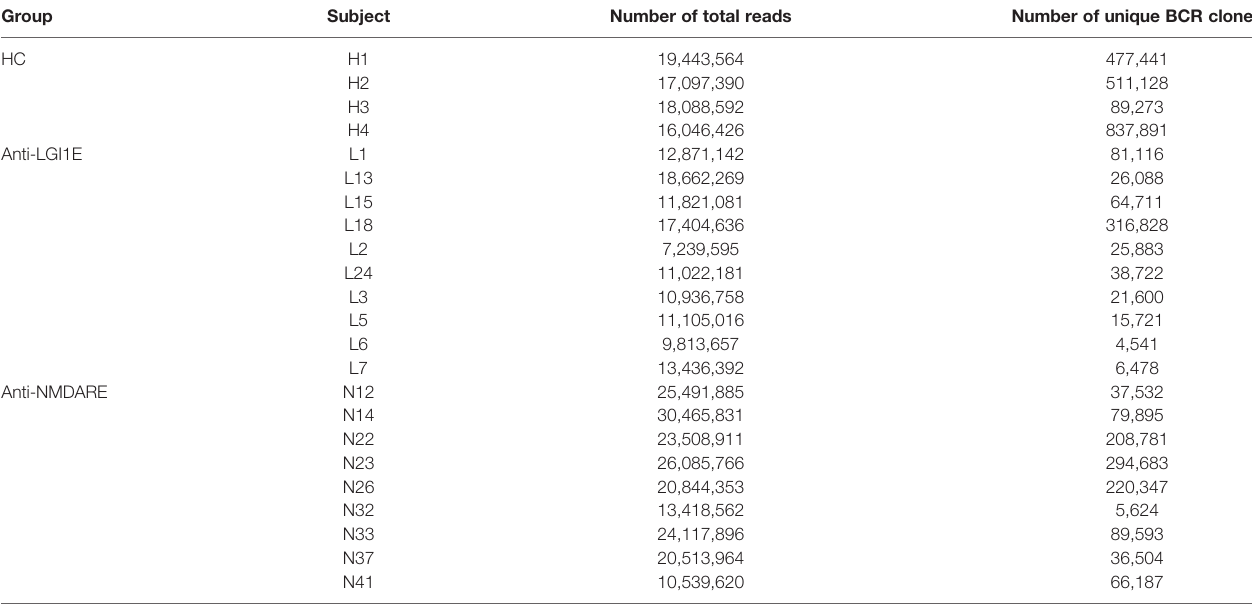
TABLE 2 | Summary of BCR heavy chain sequencing data from the anti-NMDARE, anti-LGI1E, and HC groups.